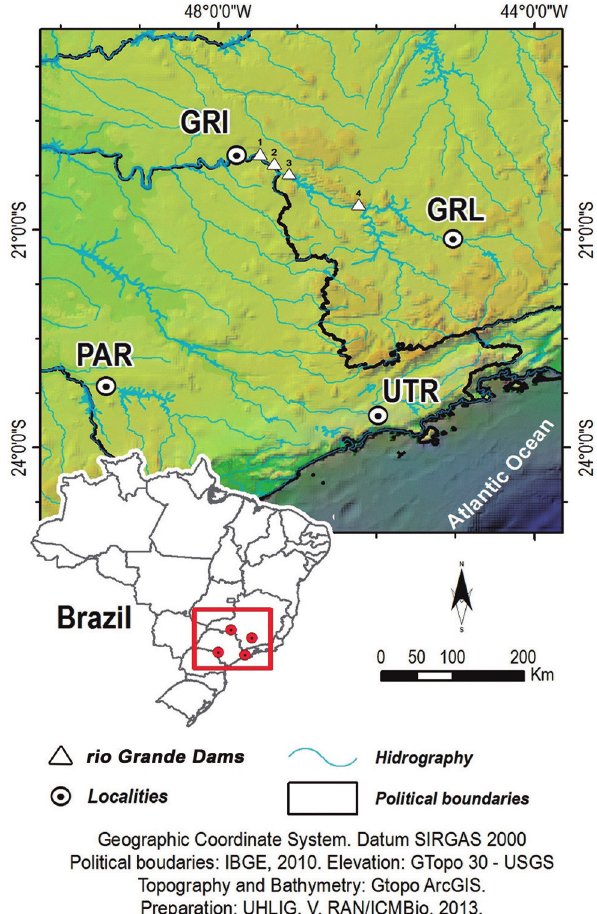
Fig. 1. Sampling sites of Salminus hilarii in the upper rio Paraná basin: rio Grande – Igarapava (GRI); rio Grande– Lavras (GRL); upper rio Tietê (UTR); rio Paranapanema (PAR). Power plants dams in the rio Grande: (1) Jaguara (built in 1971, height 71m), (2) Estreito (built in 1969, height 92 m), (3) Marechal Mascarenhas de Moraes (built in 1957, height 69 m), (4) Furnas (built in 1963, 127